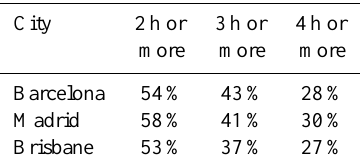
Table 5. Percentage of nucleation event days at the main cities BCN, MAD and BNE, and the uninterrupted time prevalence of these